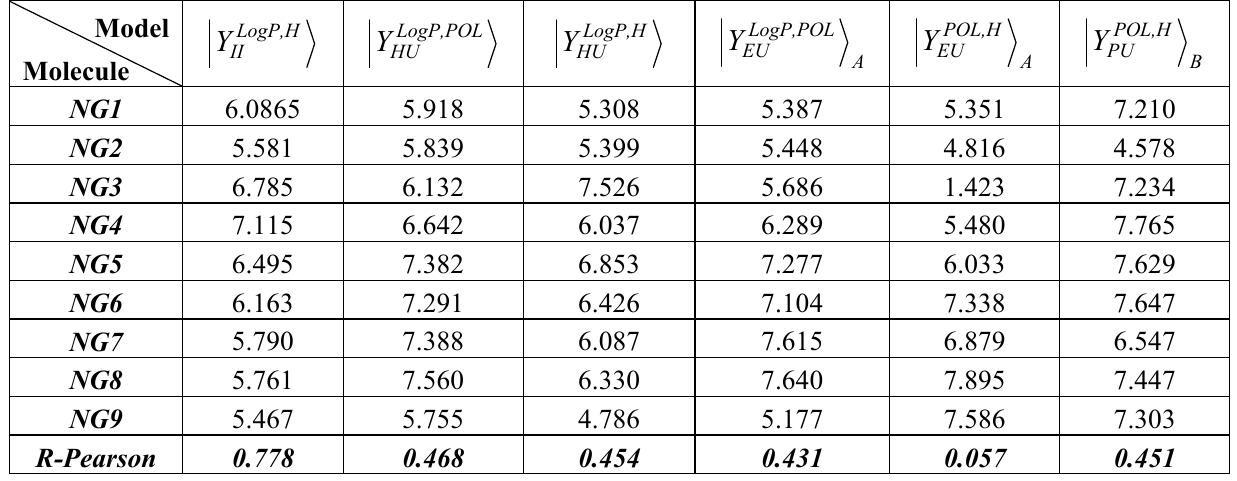
Table 11. Predicted activity as computed for the non-Gaussian molecules of Table 4 with the models of Table 6 founded along the minimum paths of Table 9; for each predicted model, its correlation with the observed activity is indicated at the bottom of the